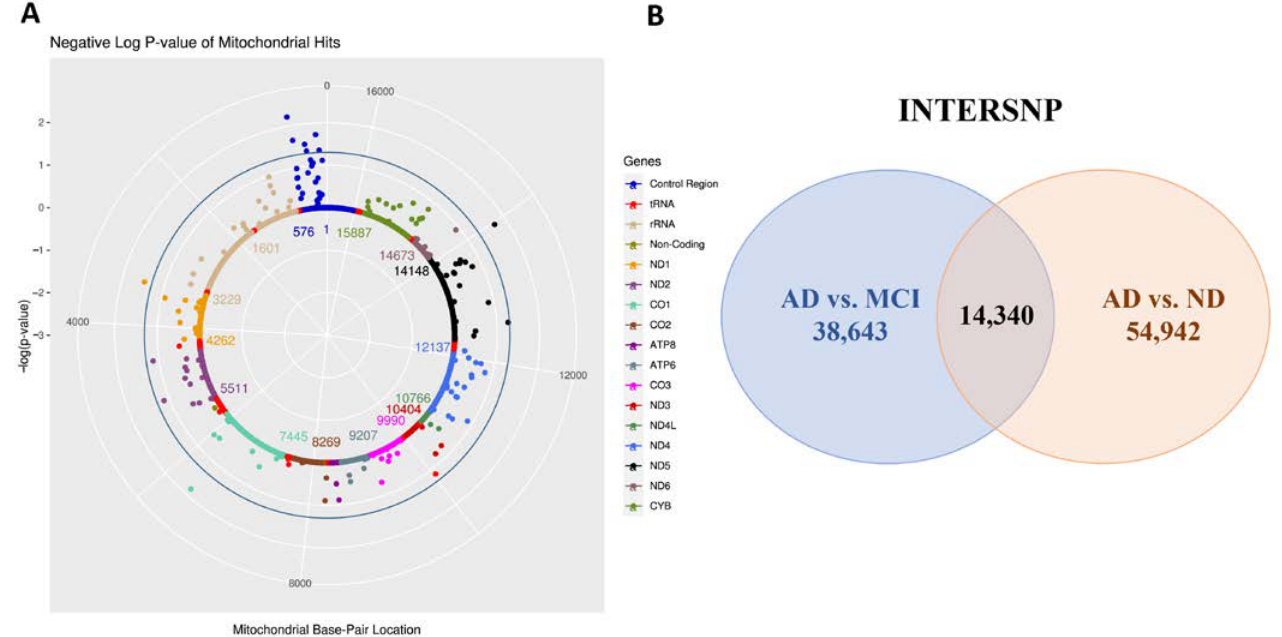
Figure 2. MiWAS result and epistasis screening. ( A ) Mitochondrial solar plot of MiWAS result. Nine MT-SNPs with a nominal p -value < 0.05 were considered statistically significant associates with AD risk (Table S1). Six of them are located in the control region of the mitochondria. ( B ) Epistasis screening of nine MT-SNPs significantly related to AD risk. A total of 54,942 (AD/no dementia) and 38,643 (AD/MCI) MT-nuclear SNP interactions met the criteria of a cell size either more than 3 or equal to 0 and a nominal p threshold of 0.05. Among them, there were 14,340 MT-nuclear SNP interactions replicated in the 2 contrast groups (Table S4).